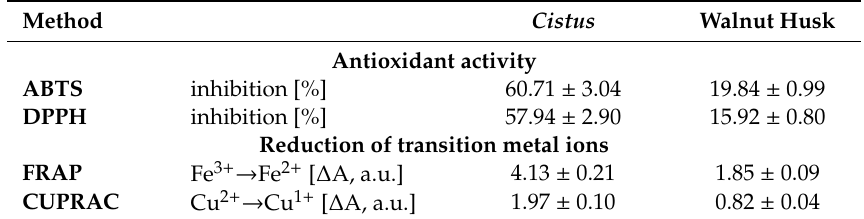
Table 1. Antioxidant activity and ability to reduce transition metal ions of the extracts of Cistus and walnut husk.